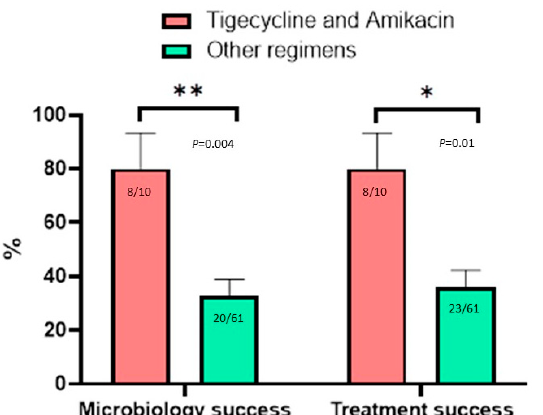
Figure 2. The outcomes of the patients with Mycobacterium abscessus complex lung disease according to treatment regimens with or without tigecycline and amikacin. ** p = 0.004, * p = 0.01.